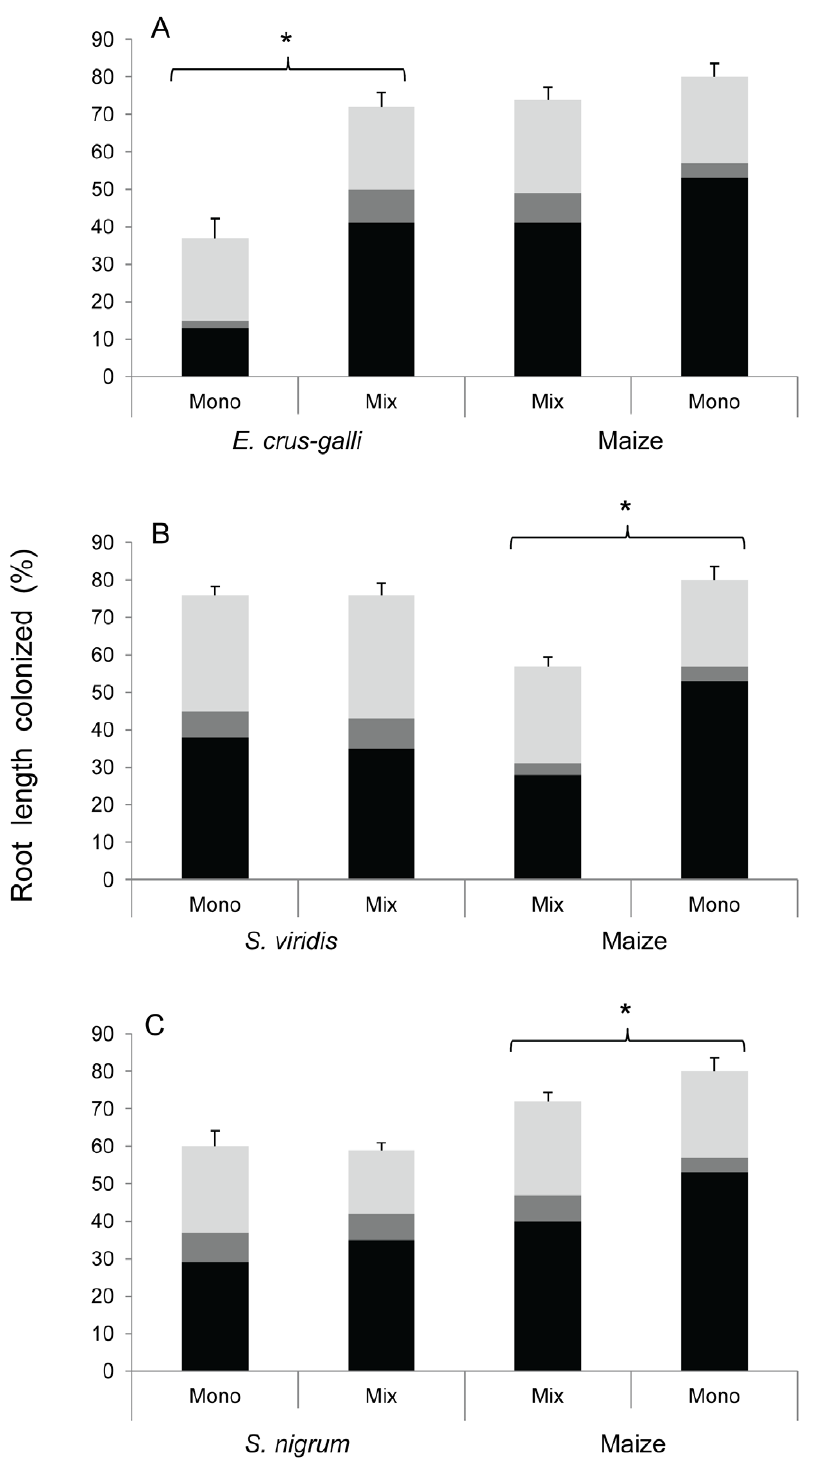
Figure 2. Percentage of total root length colonized by AMF in experiment 2. Total root length colonized by AMF (%) is represented as the sum of the percentages of root length colonized by arbuscules (black), vesicles (dark grey) and hyphae (light grey). Plant species were grown alone (Mono) or in weed-maize combinations (Mix). Bars are means of seven replicates 6 SEM. Asterisks represent significant differences in total root colonization between monocultures and mixtures, for each species. Root colonization of maize in monoculture repeated in each graph for better visual interpretation.